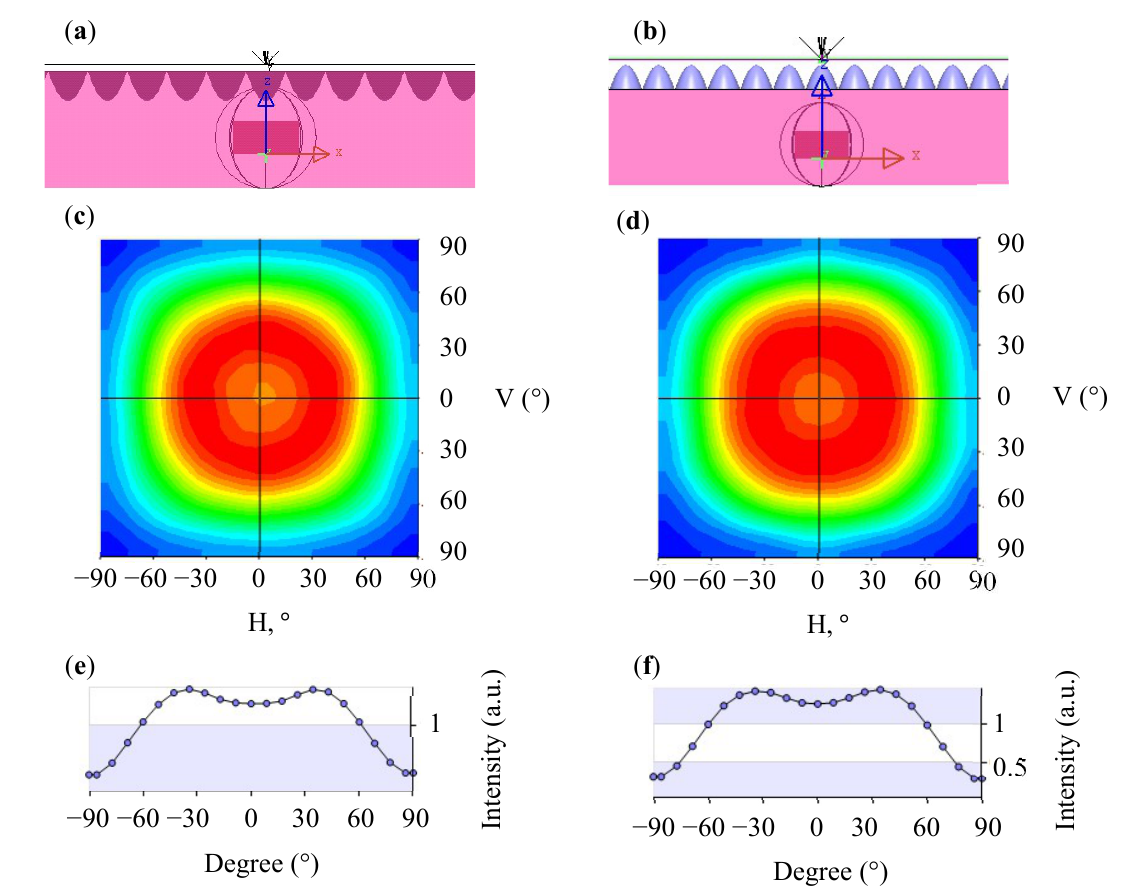
Figure 11. Simulation of the light guide layer combined with concave and convex PSMLA microstructures: ( a ) 3D-simulated structure of concave PSMLAs; ( b ) 3D-simulated structure of the convex PSMLAs; ( c ) plane rectangular light distribution curve of concave PSMLAs; ( d ) plane rectangular light distribution curve of convex PSMLAs; ( e ) horizontal section light distribution curve of concave PSMLAs; ( f ) horizontal section light distribution curve of convex PSMLAs.